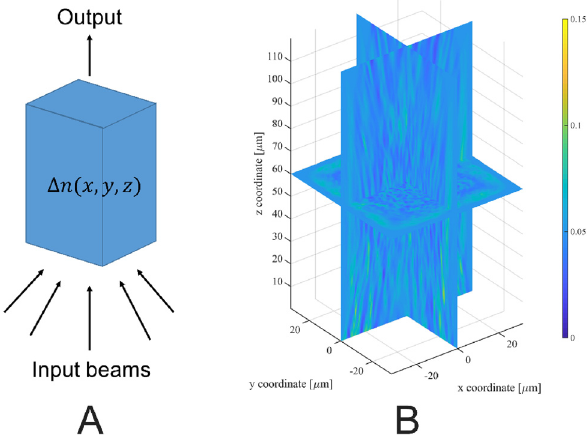
Figure 7: (A) Multiplexing scheme with GRIN volume element where Δ n ( x , y , z ) standsfor RI variation.(B)XY, YZ andXZ cutplanes of the optimized volume by LT. Colorbar shows RI